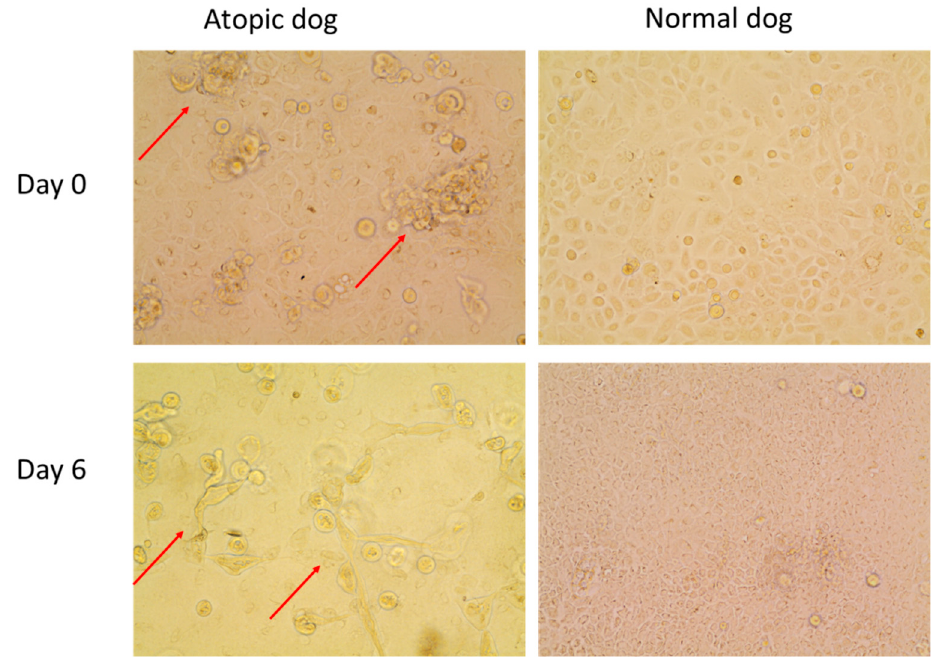
Figure 10. Pictures of unstained cell cultures of normal and atopic dogs at day 0 (first day of confluence) and day 6. Note how the atopic cells create little irregular accumulations of cells (“domes”) as indicated by the red arrows, while the normal cells are more evenly distributed, creating a flat monolayer.